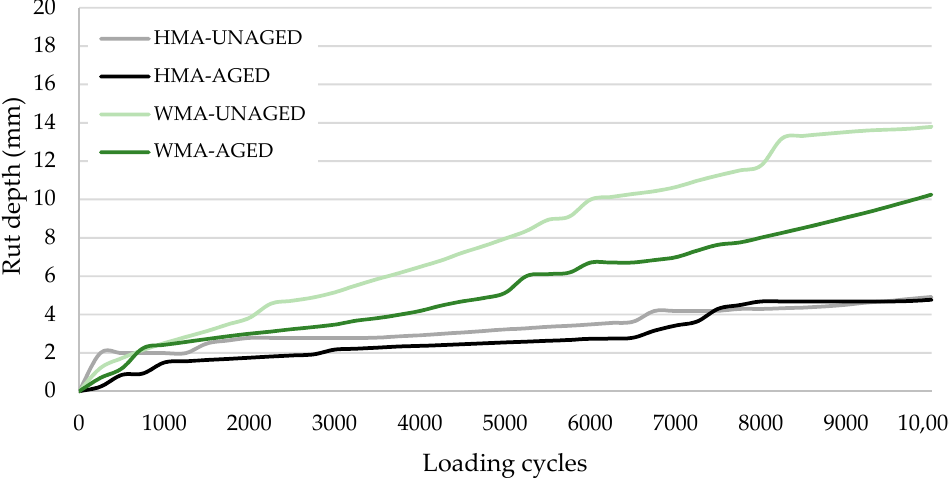
Figure 7. Results of indirect tensile strength ratio (ITSR) values.